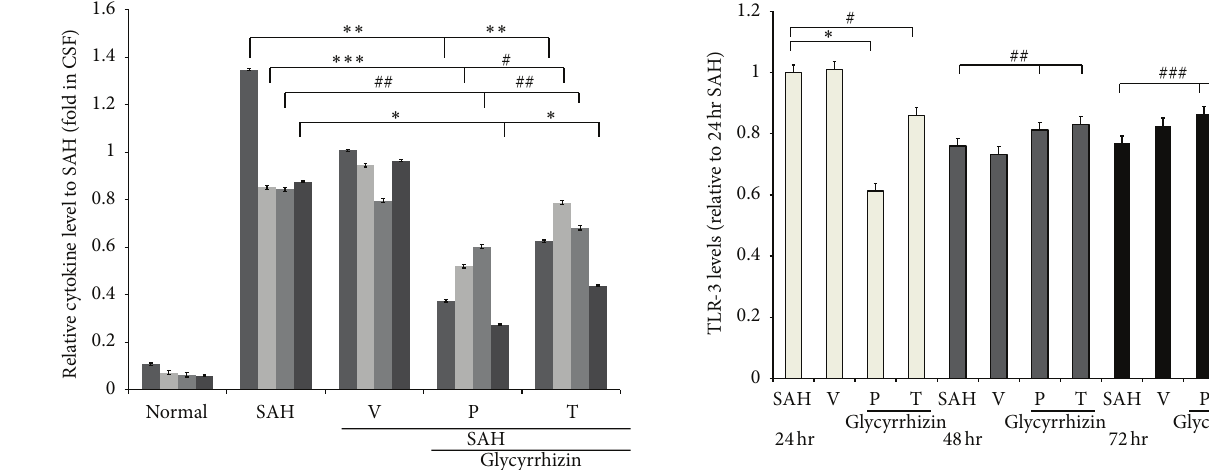
Figure 4: Toll-like receptor 3 (TLR-3) expression on 24, 48, and 72 hr, respectively (Western blot). All groups are identical to those shown in the legend of Figure 3. ∗ : 𝑃 < 0.01 ; # , ## , ### : 𝑃 > 0.05 represent glycyrrhizin treatment (24 hr), precondition and treatment with glycyrrhizin (48 and 72hr, resp.), compared with the SAH groups.